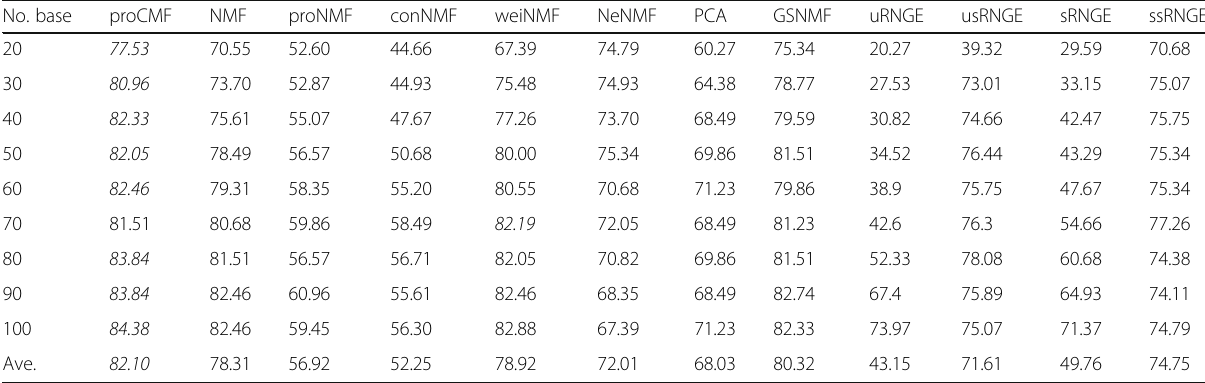
Table 4 Facial expression recognition rate (%) using the JAFFE dataset with different subspace dimensionalities (case 2: no. training = 2) No.